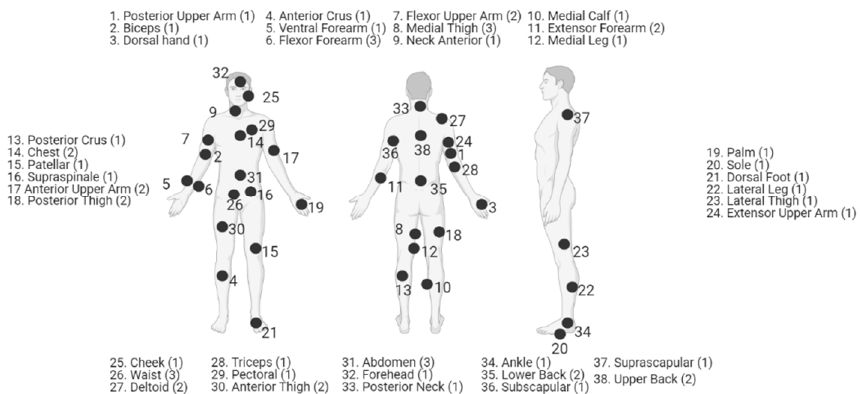
Figure 7. Relative total skin thicknesses across body sites for a sample of studies, from thinnest to thickest. Each anatomy also has (1), (2), or (3) next to its name, indicating the number of studies this body site was measured in (out of 5 considered works). Created with BioRender.com